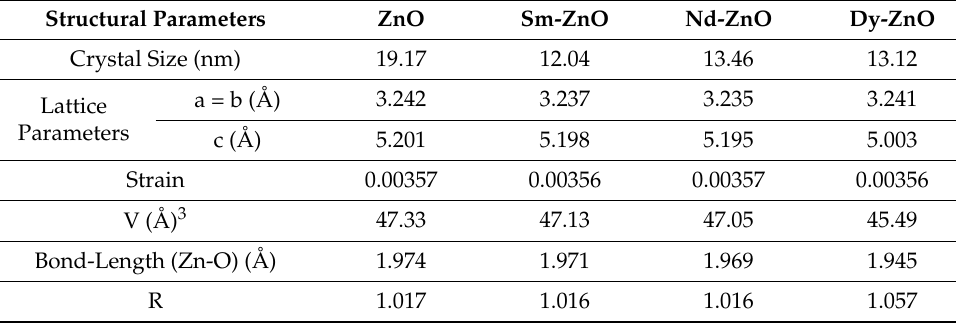
Table 1. Structural parameters of rare earth doped ZnO nanoparticles. Structural